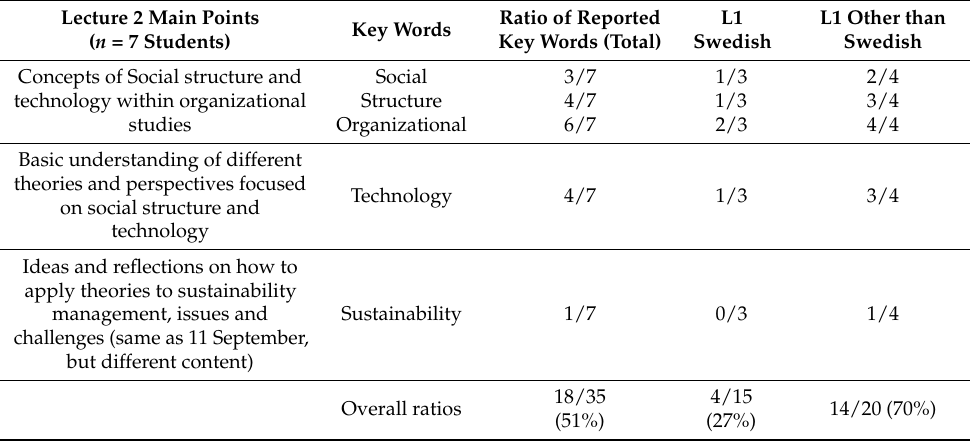
Table 3. Lecture 2 main idea key words comparison.